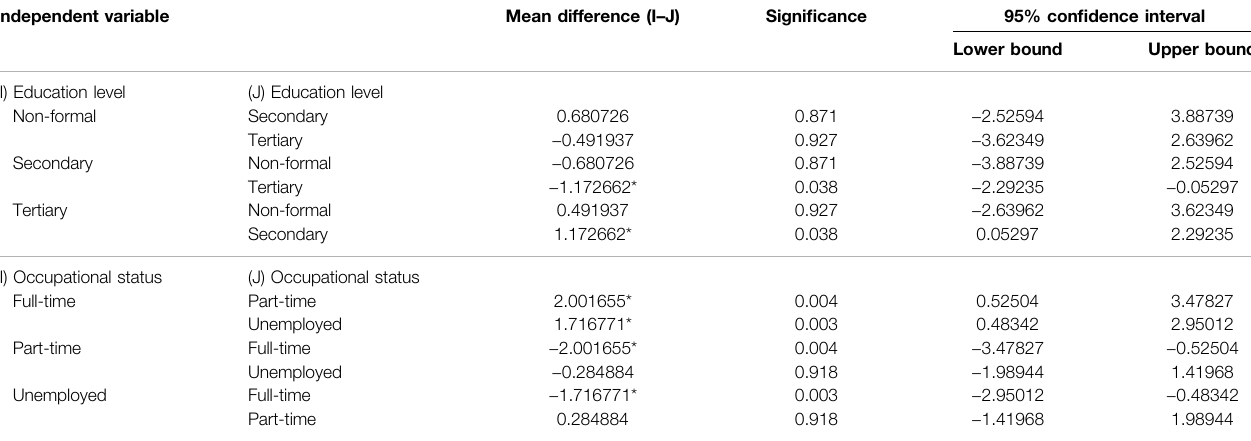
TABLE 8 | Post hoc test for home – public transportation station distance with education level and occupational status. Independent